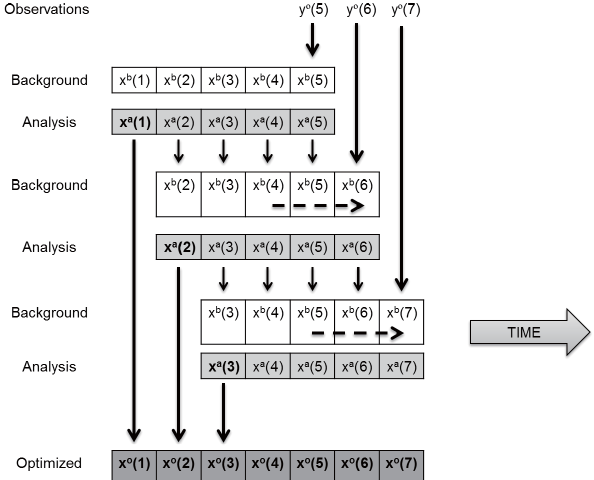
Figure 1. Schematic diagram of the assimilation process employed in CarbonTracker. In each analysis cycle, observations made within 1 week are used to update the state vectors with a 5-week lag. The dashed line indicates how the simple dynamic model uses analysis state vectors from the previous 1 and 2 weeks to produce a new background state vector for the current analysis time. The TM5 model is used as the observation operator to calculate the model CO 2 concentration for each corresponding observation location and